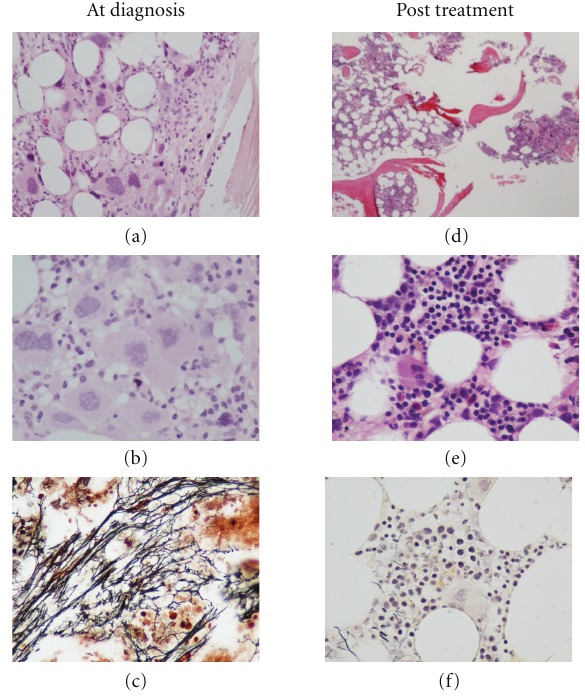
Figure 1: (a, b, c) relatively hypercellular marrow with marked fibrosis, abundant atypical megakaryocytes, and scattered imma- ture-appearing cells, (a, b) H&E-stained sections, (c) reticulin stain). (d, e, f) following treatment with lenalidomide, the bone marrow showed patchy hematopoiesis with areas of high and low cellularity ((d) H&E-stained section), decreased numbers of meg- akaryocytes ((e) H&E-stained section) and a marked reduction in reticulin fibrosis ((f) reticulin